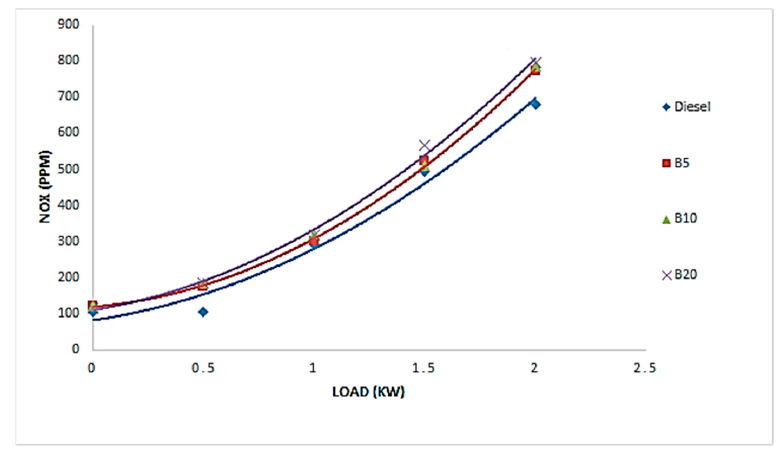
Figure 13. NOx vs. load